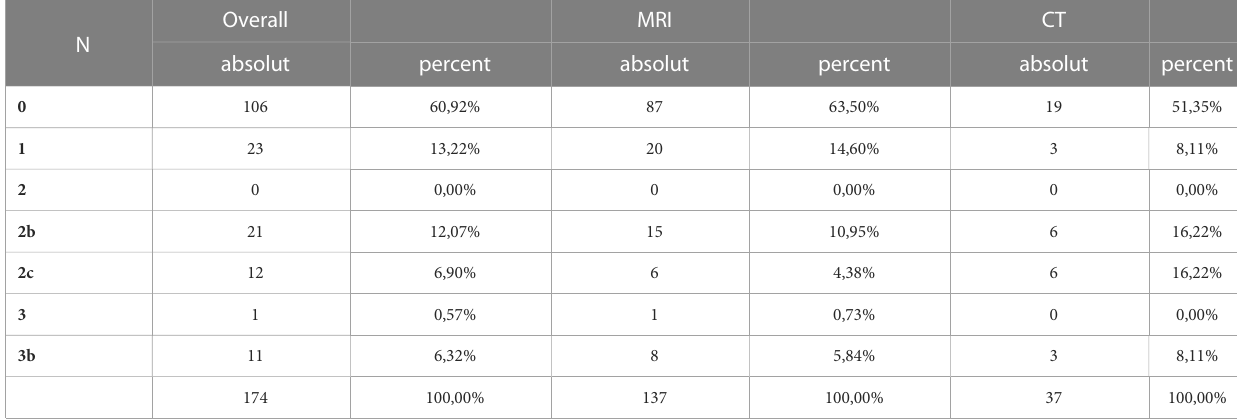
TABLE 4 cN status of 174 patients according to MRI, CT and overall groups.